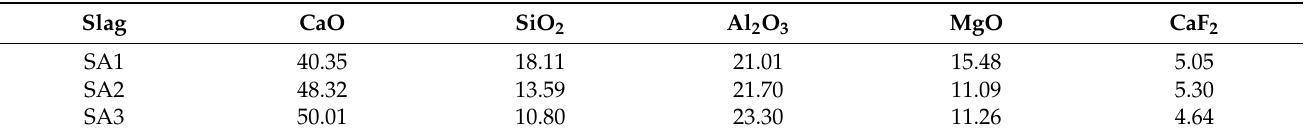
Table 3. Chemical composition of the steel samples following the metal/slag reaction (mass percent- age).